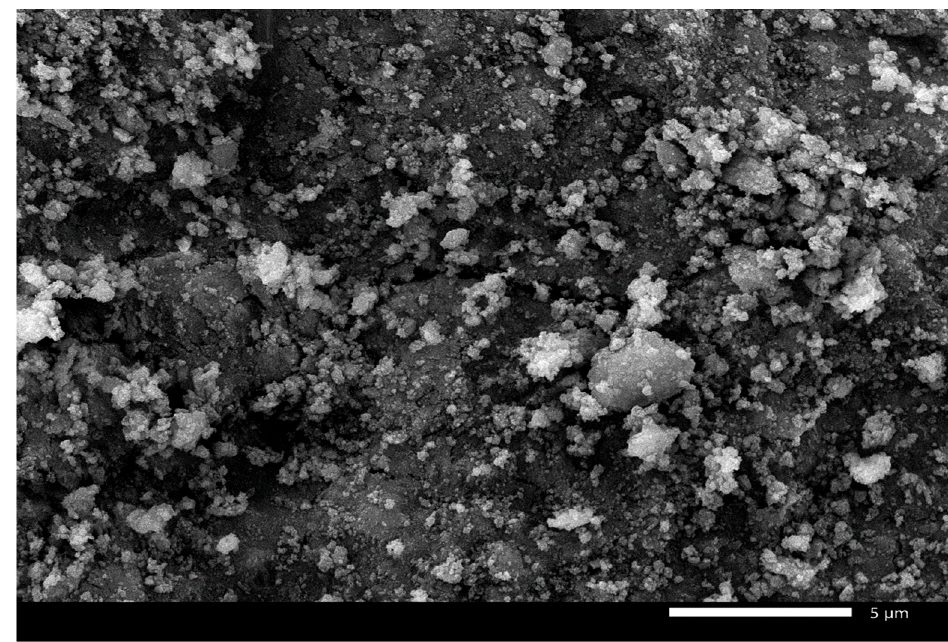
Figure 21. Photo of the spent catalyst after the blank test obtained during scanning electron micros- copy (SEM).